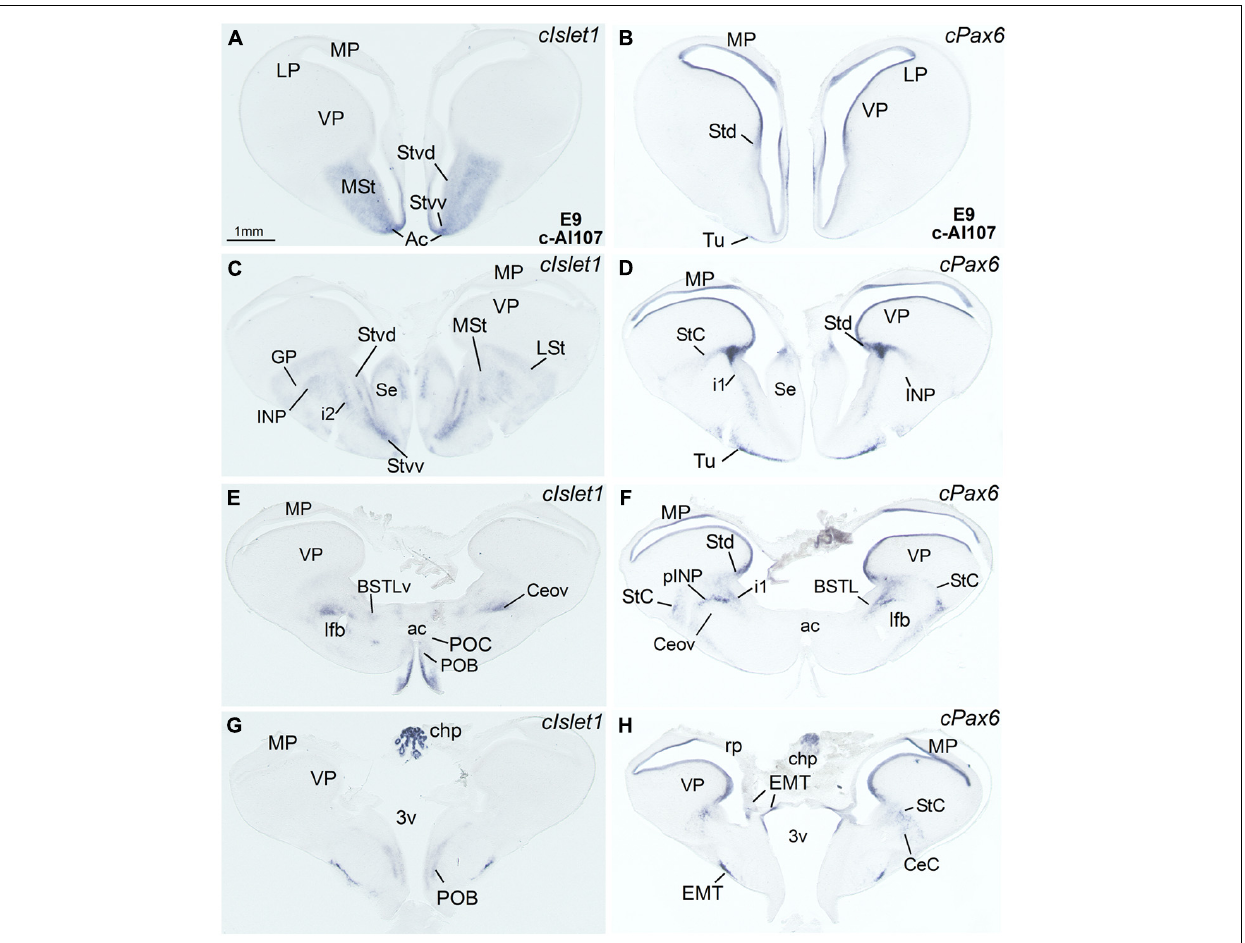
FIGURE 2 | Expression of cIslet1 and cPax6 in the telencephalon of chicken embryos at E9. (A–H) Low-magnification digital images of frontal telencephalic sections of the chicken embryo (E9), from rostral (A,B) to caudal (G,H) levels, hybridized for cIslet1 or cPax6 . i1 points to a tangentially